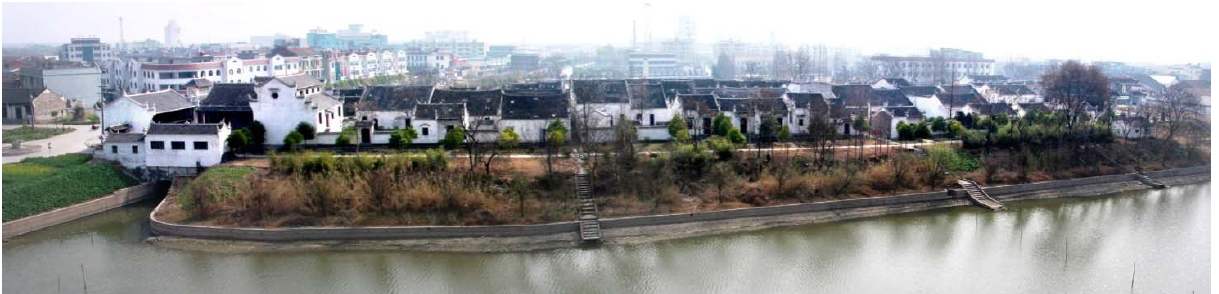
Figure 29. Zhai J.W. Village photo from river side